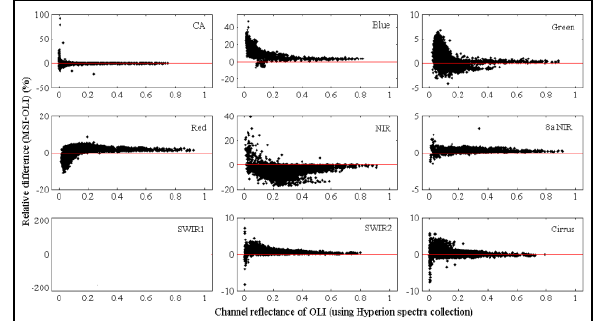
Figure 3. Same as Figure 2, but results based on samples from Hyperion spectra collection. The plot for SWIR1 is not shown due to strong impacts of atmosphere on radiometric calibration.